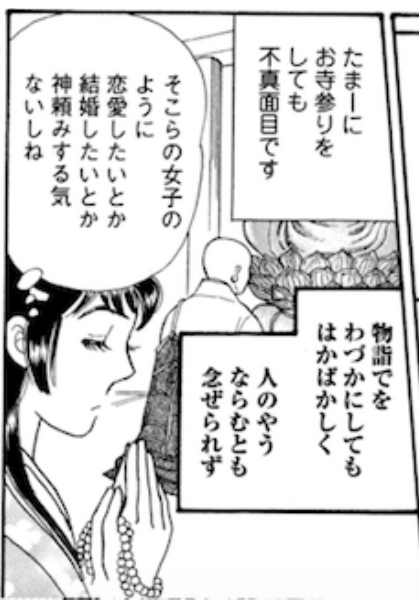
Figure 12. Left. Heroine does not feel like doing what society expects from her